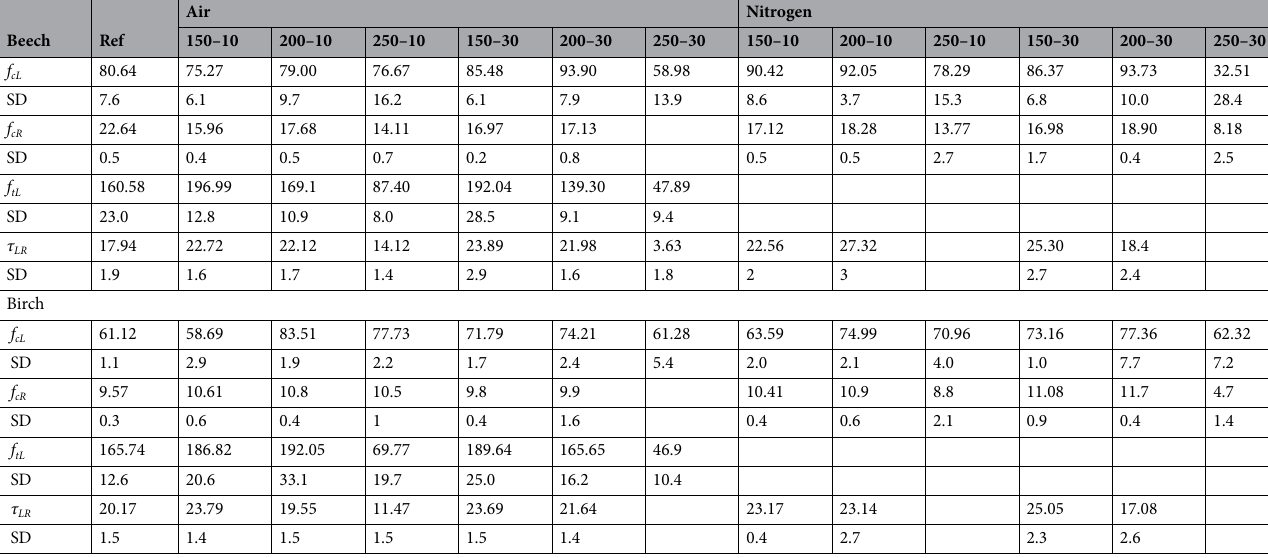
Table 2. Mean strength values (MPa) and their standard deviation % (SD) for heat-treated and untreated beech and birch by quasi-static tests (the first number refers to the treatment temperature and the second number refers to the duration time in minutes).